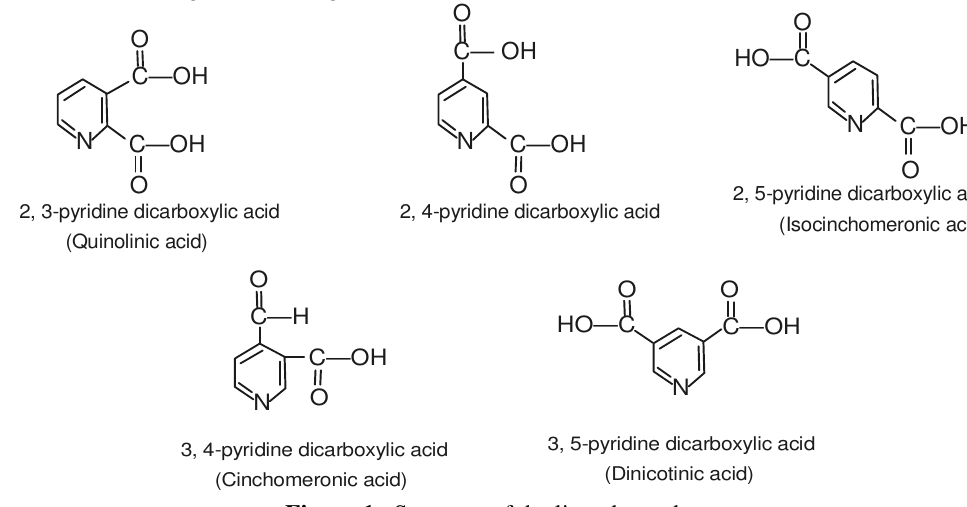
Figure 1. Structure of the ligands